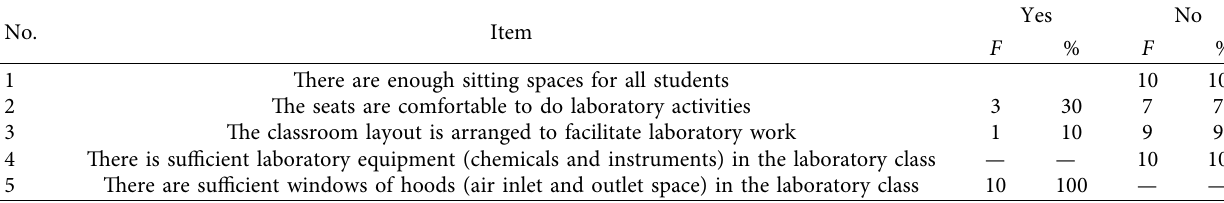
Table 5: Condition of the laboratory